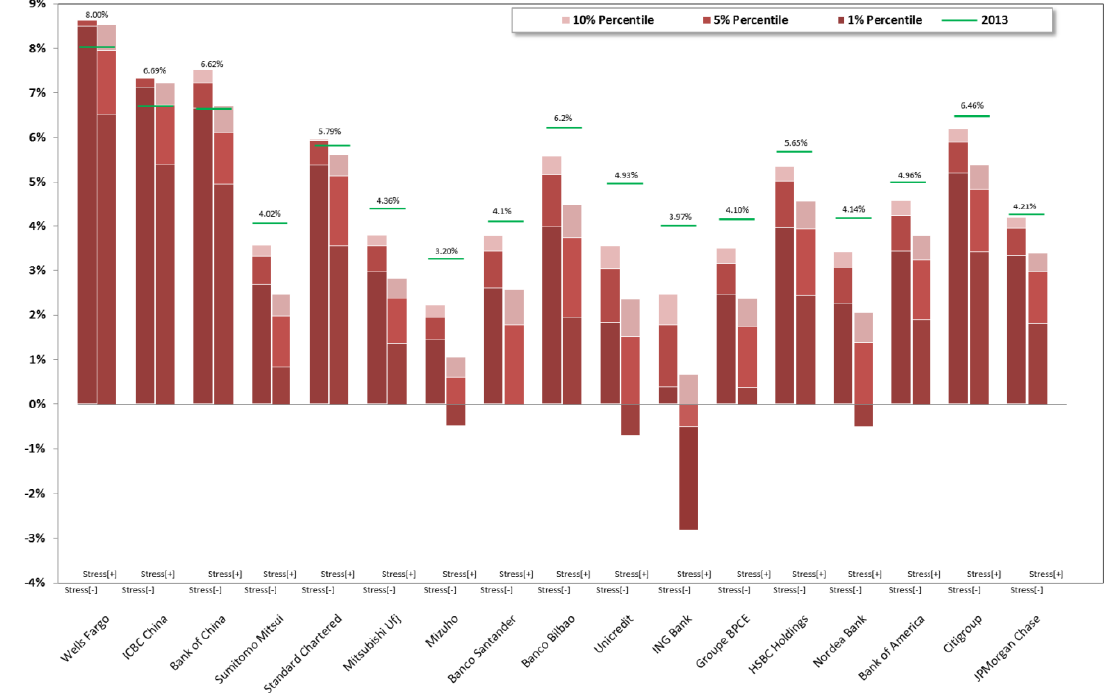
Figure 4. Stressed leverage ratio 2015 vs. leverage 2013. CB & CBU.